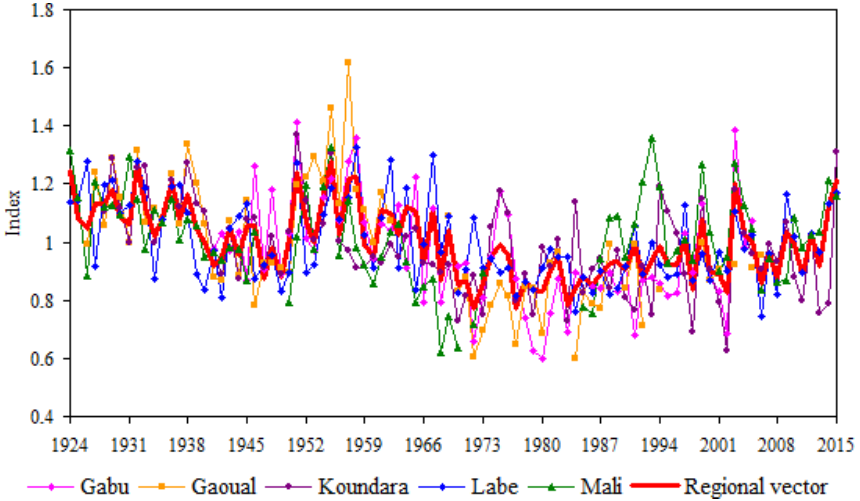
Figure 5. Annual vector of rainfall index over the period 1924–2015 and index of Gabu, Gaoual, Koundara, Labe and Mali